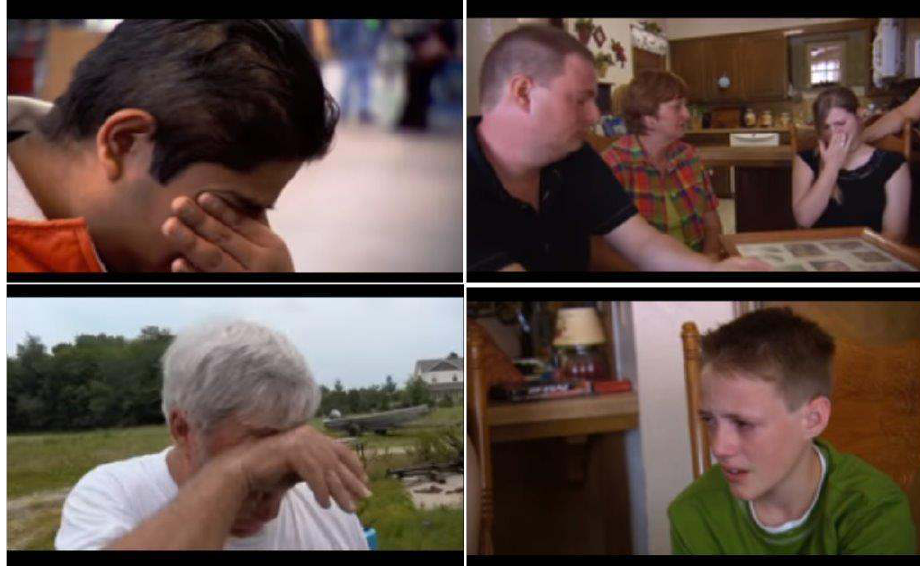
Source: Capitalism, A Love Story by Michael Moore (screen